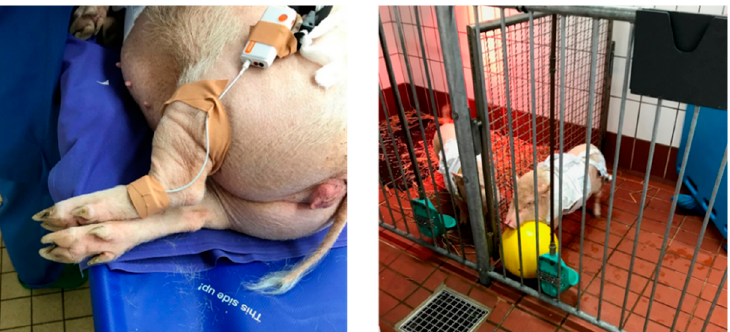
Figure 2. The PPG sensor is placed on the left back leg (below the knee) of the non-anaesthetised pig (left photo) and then the animal is allowed to move freely in a pen (right photo).